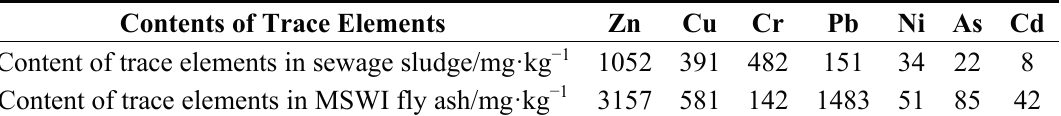
Table 2. Heavy metal concentrations of the sewage sludge and MSWI fly